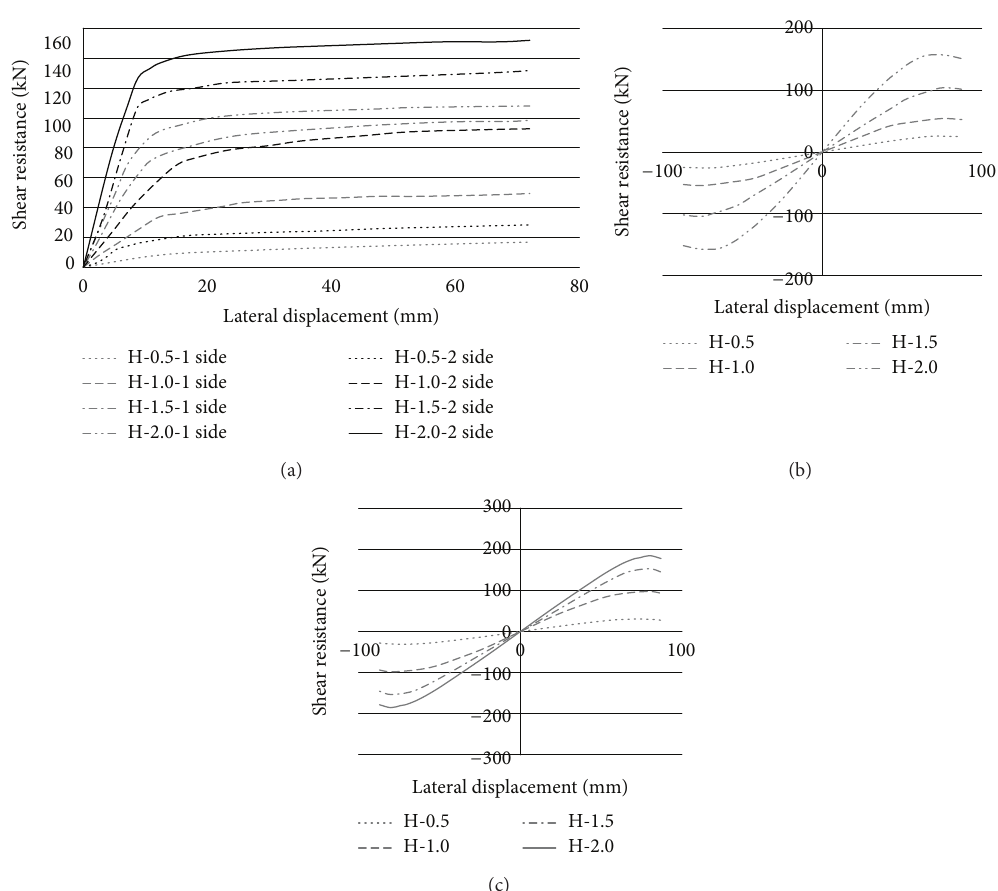
lateral braces, a mean value of ductility equal to 2.30 has been used and the value of 𝑅 𝑑 was evaluated as 1.89. Since the value of ( 𝑆 𝑦 / 𝑆 𝑦𝑝 ) is less than 1, there is no additional